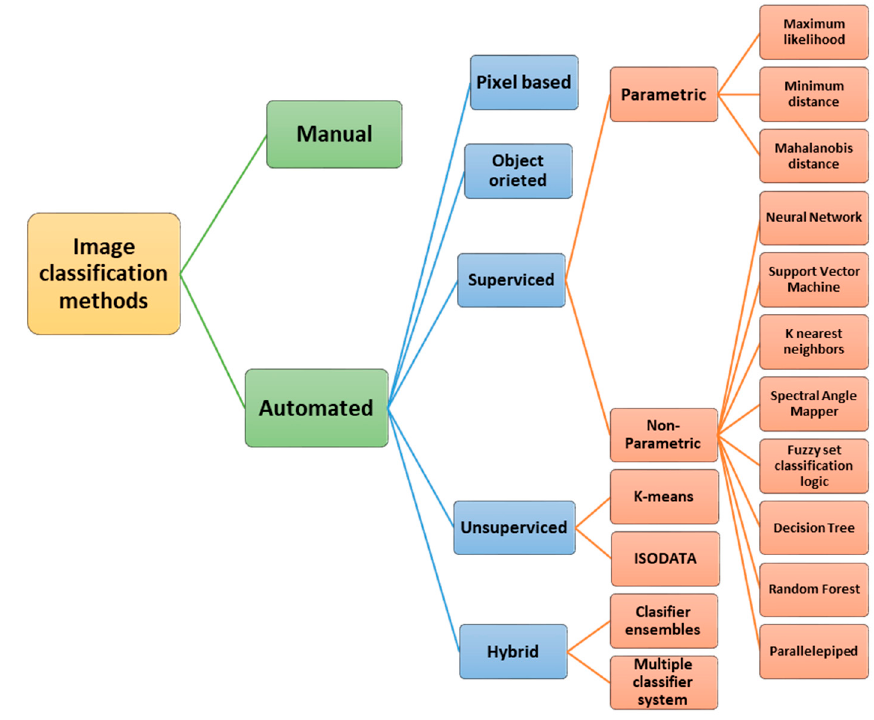
Figure4. Figure 4. Image classification methods for land-use change detection and soil erosion hazard assessment.